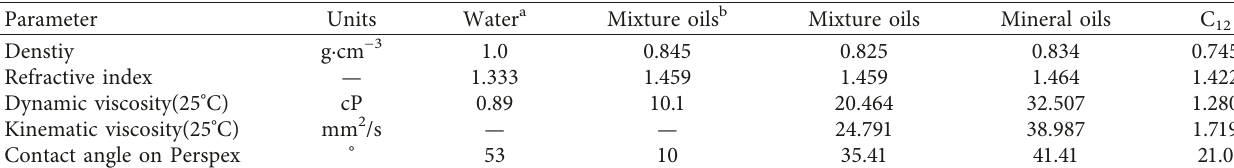
Table 2: Oil and water